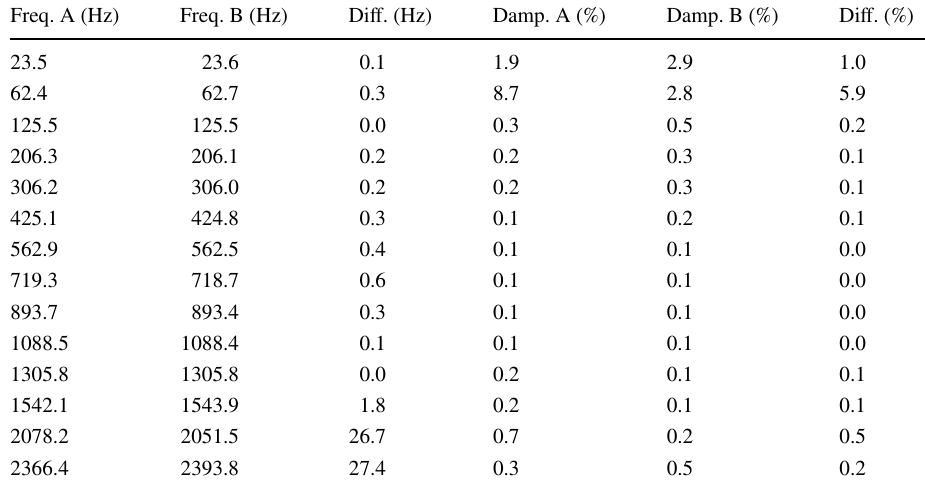
Table 3 The identified natural frequencies of the investigated rock bolt, measurement with a the working prototype and b final version